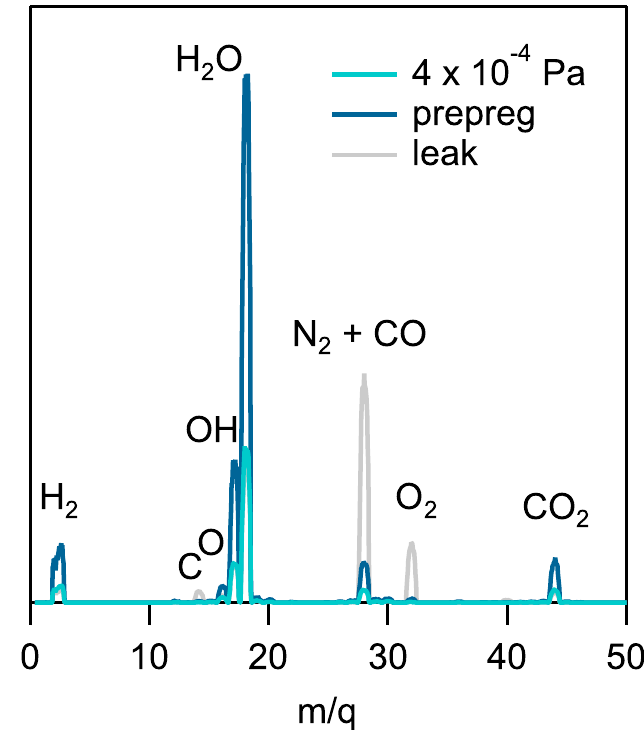
Figure 6. Residual gas analysis for a background pressure of 4 × 10 − 4 Pa, a vacuum with a prepreg substrate introduced and a leak of atmospheric gas into the vacuum chamber. The vacuum chamber had a total volume of 0.125 m 3 and was sealed by means of rubber